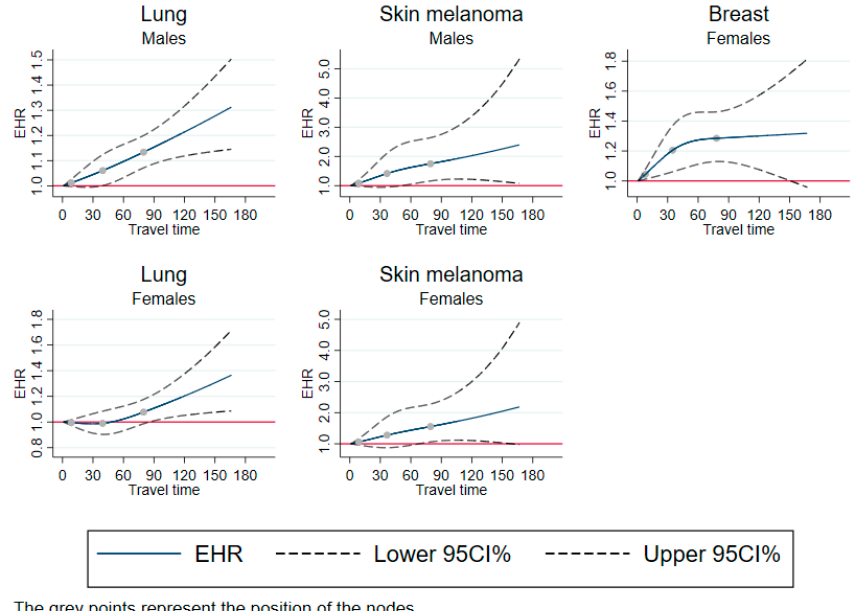
Figure 1. Excess mortality rates as a function of travel time, using restricted cubic splines—cases with linear pattern. EHR: excess hazard ratio; CI: confidence Interval; travel time: travel time in minutes. Adjusted for year of diagnosis, age, and European Deprivation Index.